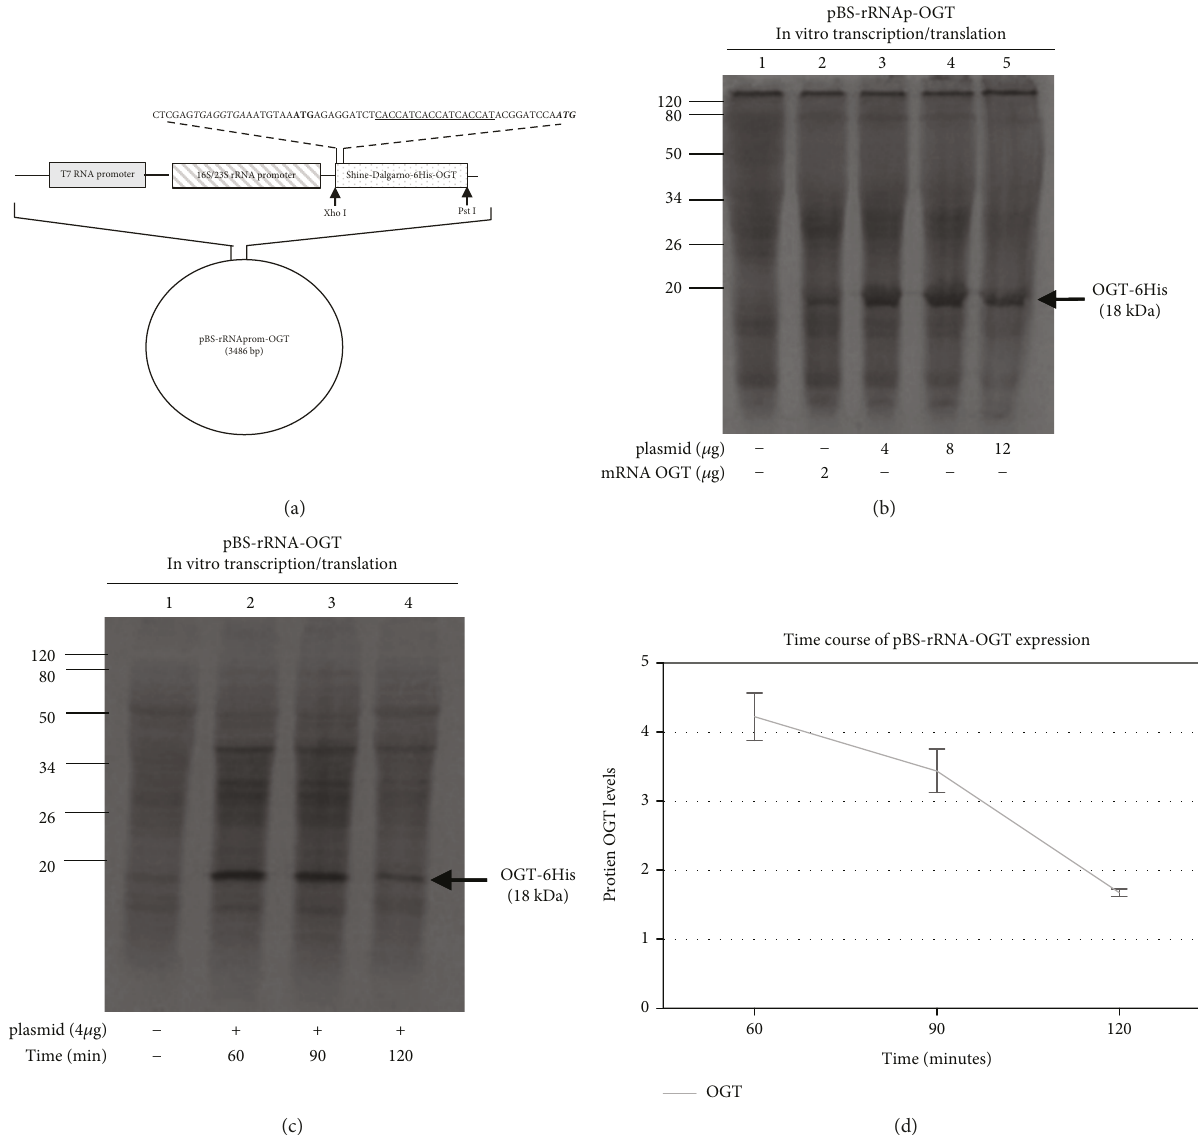
Figure 4: In vitro expression of OGT. (a) Schematic representation of the pBS-rRNA - ogt plasmid. It was designed by introducing a DNA p fragment of 522bp containing the ogt gene into the Xho I- Pst I sites replacing ORF 104. The coding region starts with an AUG codon (bold letters) preceding a DNA region coding for six histidines (underlined letters) placed to the amino terminal region of the OGT protein (bold and italic letters). The DNA insert contains an SD motif (italic letters) retained from the ORF 104 and located 7 nucleotides upstream from the coding region. (b) Increased amounts of the pBS-rRNA - ogt plasmid were incubated with S. solfataricus whole cell p extract for 60min at 70 ° C in a fi nal volume of 25 μ l, and the products of expression were resolved by 16% denaturing polyacrylamide gel - ogt plasmid were incubated with S. solfataricus whole cell extract electrophoresis. (c) Time course of OGT expression: 4 μ g of pBS-rRNA p at 70 ° C and equal aliquots of the reaction were withdrawn from the mixture at the indicated times. (d) A graph is plotted with the values of the band intensity corresponding to the OGT protein shown in (c) and quanti fi ed using ImageJ software (NIH). The values represent the average of three independent experiments. All error bars indicate